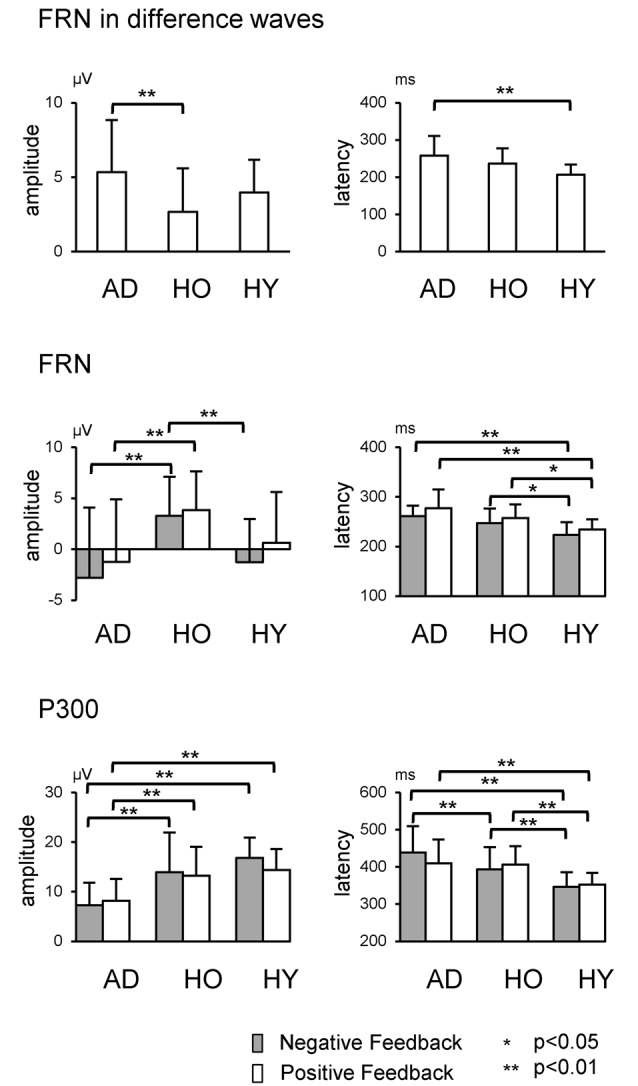
Each row shows data relating to FRN at Fz and P300 at Pz, respectively. Error bars denote standard deviations.